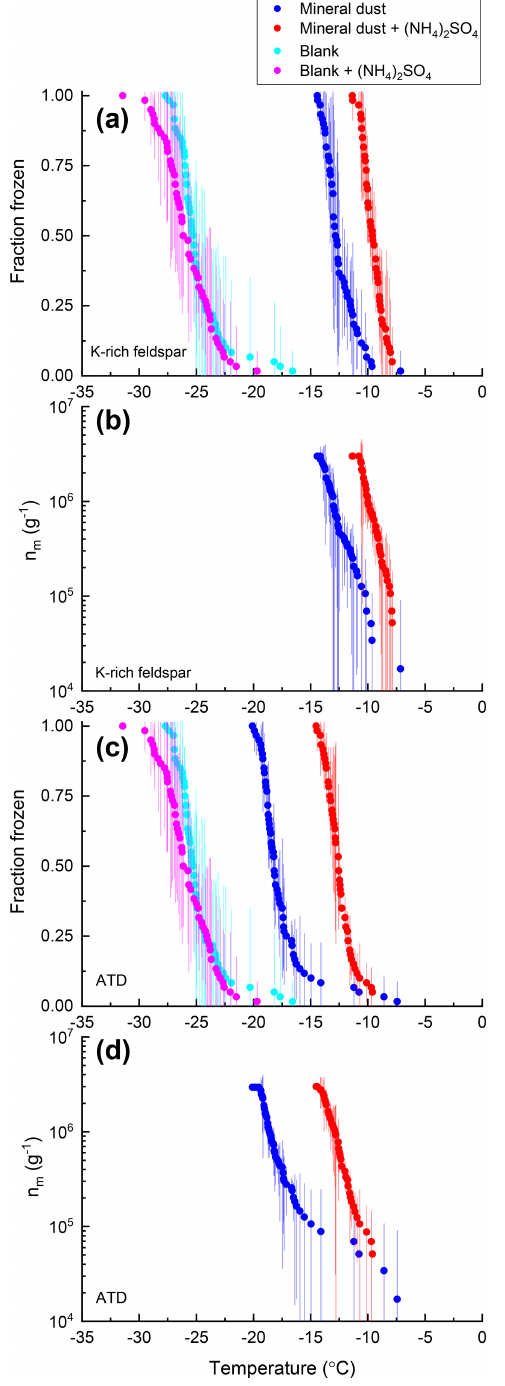
Figure 9. Fraction of droplets frozen (a, c) and ice nucleation ac- tive site densities n m (T ) (b, d) for samples of Arizona Test Dust (a, b) and K-rich feldspar (c, d) with (red) and without (blue) 0.05M(NH 4 ) 2 SO 4 compared with an ultrapure water blank with (pink) and without (cyan) 0.05M(NH 4 ) 2 SO 4 . Freezing data (both samples and blanks) have been corrected for freezing point depres- sion by 0.05M(NH 4 ) 2 SO 4 . Error bars represent the 95% confi- dence interval of fraction frozen or n m (T ) at temperature T calcu- lated using Student’s t distribution.